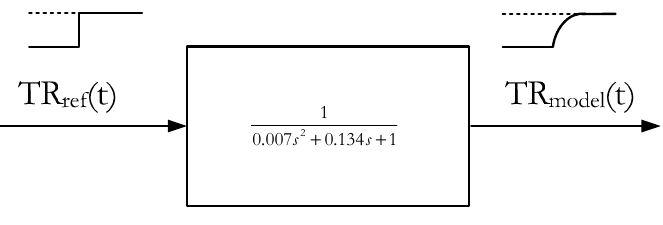
Figure 2. Second order response model of the electric motor.